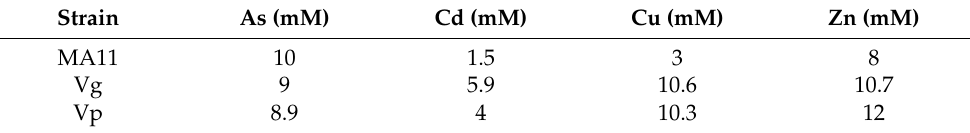
Table 1. Maximum tolerable concentration of metal/loid. Strain As (mM)